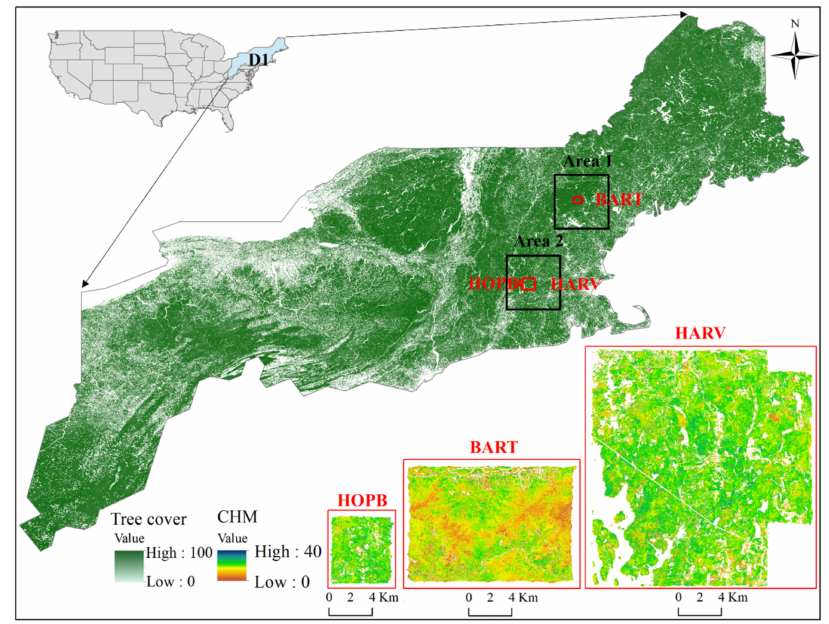
Figure 2. Locations of study areas. The black rectangles show the locations of Area 1 and Area 2 with 1 ◦ × 1 ◦ tiles in the ecoregion domain of the North American eastern forests. Three red rectangles represent the locations of three NEON sites, including the BART, HOPB, and HARV. The tree